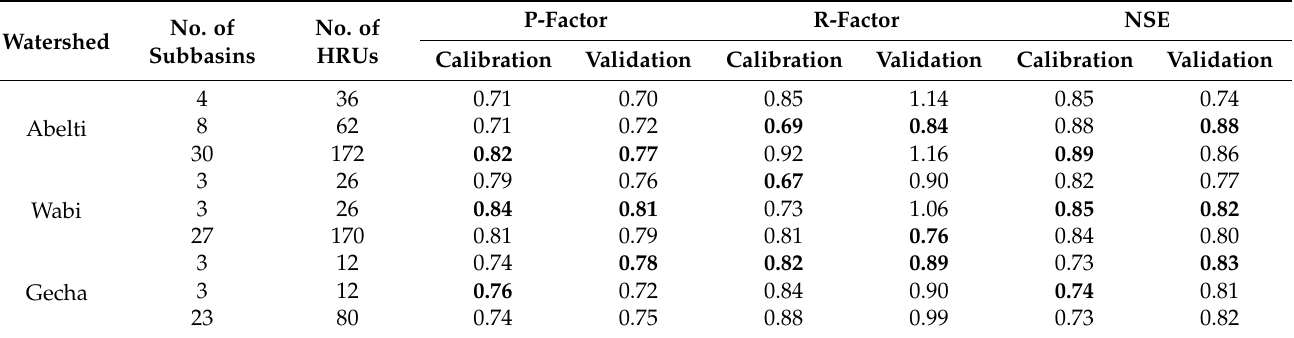
Table 2. SWAT model metric valuation over the calibration and validation